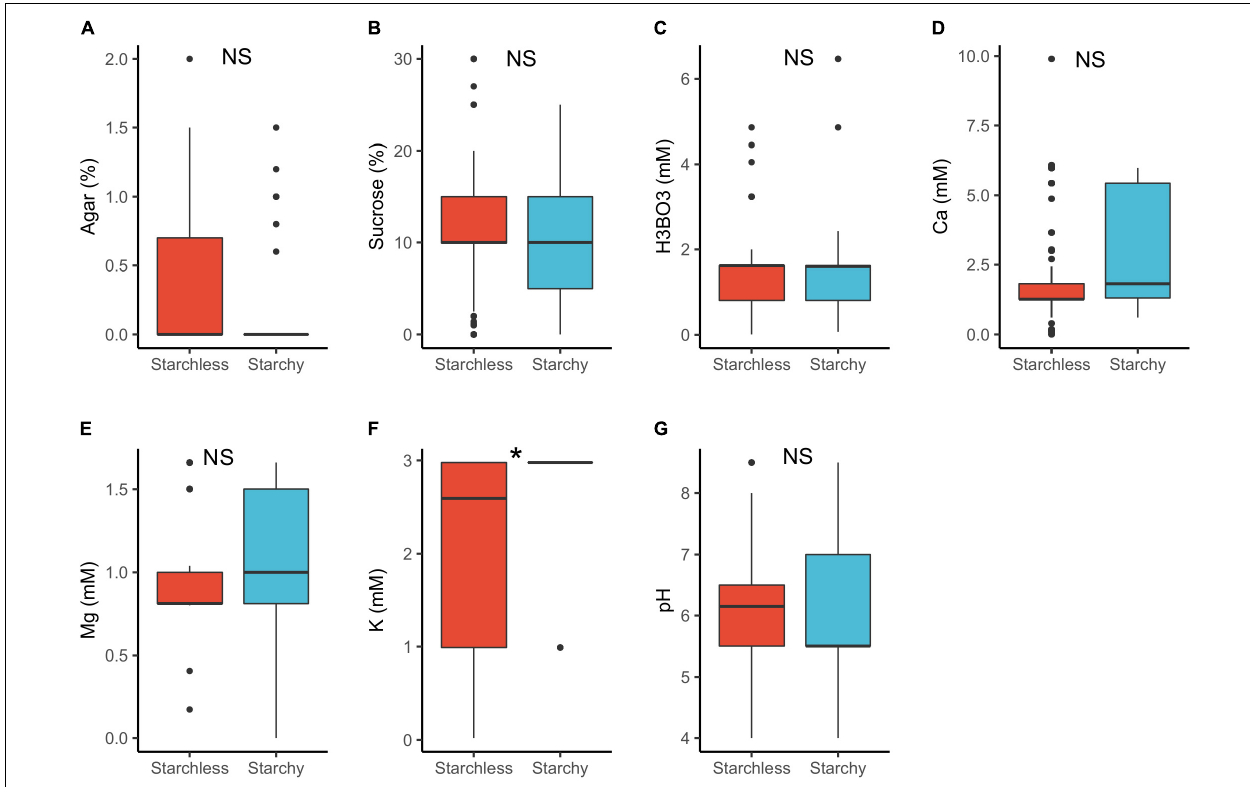
FIGURE 6 | Pollen germination media requirements for starchy ( n = 86) and starchless pollen ( n = 268): agar (A) , sucrose (B) , boric acid (C) , calcium (D) , magnesium (E) , potassium (F) , and pH (G) . *, significant ( p < 0.05); NS, not significant.